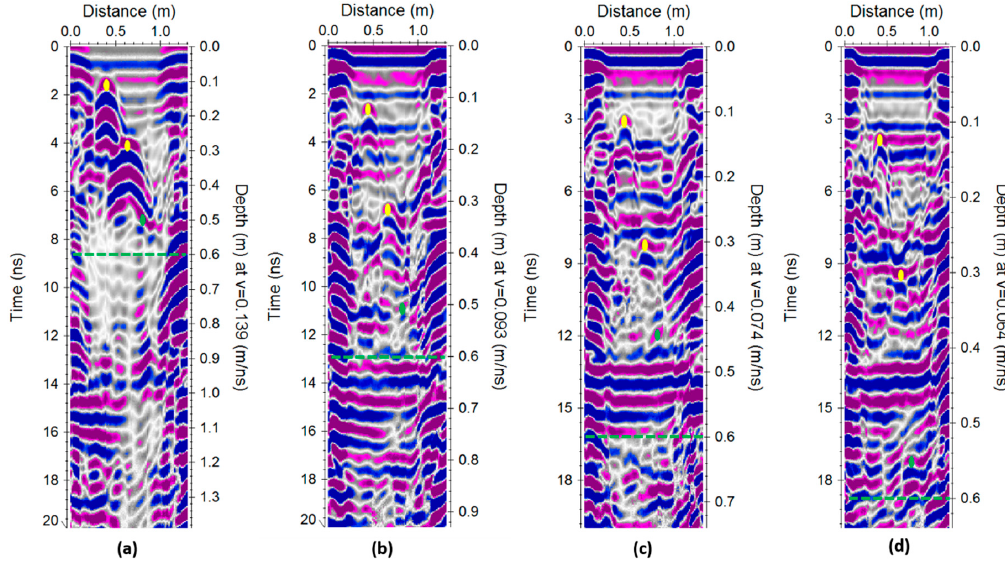
Figure 10. Representative GPR sections in the small loess soil box with different amounts of water added to the soil box. ( a ) No added water; ( b ) 25 L added water; ( c ) 55 L added water; ( d ) 80 L added water; the calculated moisture contents were 2.6 ± 0.6%, 9.8 ± 0.9%, 17.3 ± 1.1%, and 24.7 ± 1.3, respectively. The yellow markers indicate the clearly identified diffractors, and the green markers indicate the approximate location of the targets that are expected to have provided diffractions and reflections.